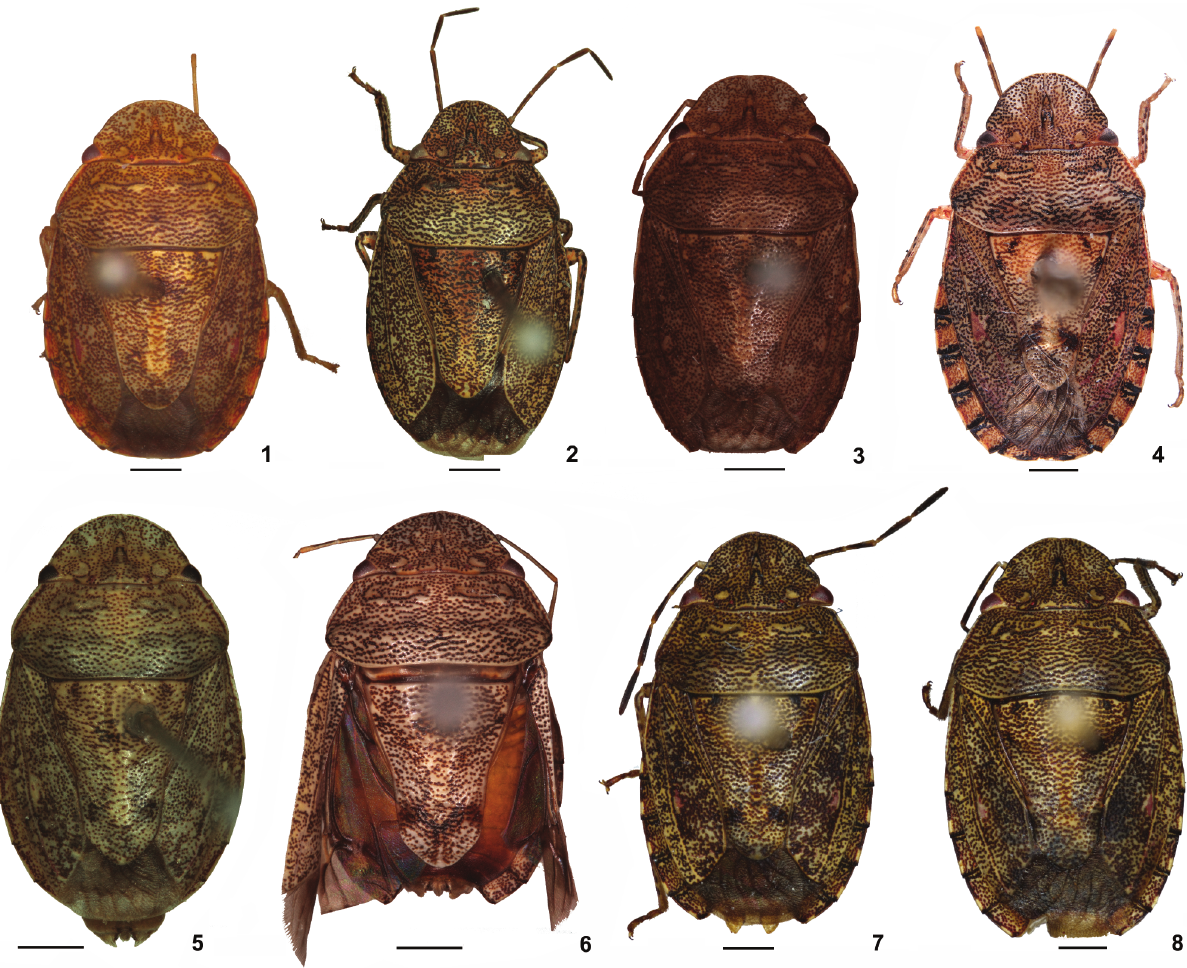
Figures 1–8. Lineostethus , dorsal aspect: (1) L. clypeatus (female); (2) L. tenebricornis (male paratype); (3) L. marginellus (male); (4) L. graziae (female holotype, photo by Mike Narahara – CAS); (5) L. sinuosus sp. nov. (male holotype); (6) L. acuminatus sp. nov. (male holotype); (7) L. otarus sp. nov. (male holotype); (8) L. auritus sp. nov. (male holotype). Scale bars: